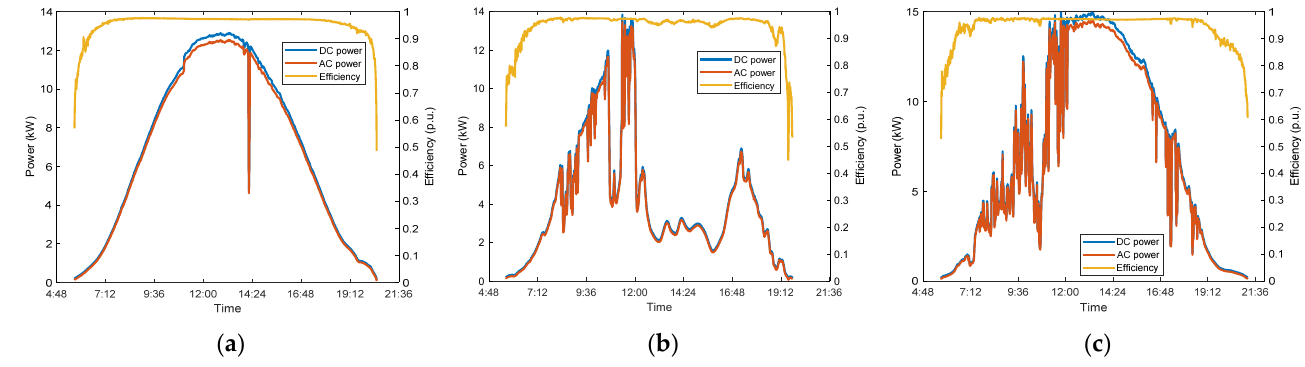
Figure 7. Examples of the recorded profiles of the reference inverter input DC power, output AC power and efficiency during three days with different cloud conditions: ( a ) 16 July 2021 ( b ) 17 July 2021 ( c ) 18 July 2021.